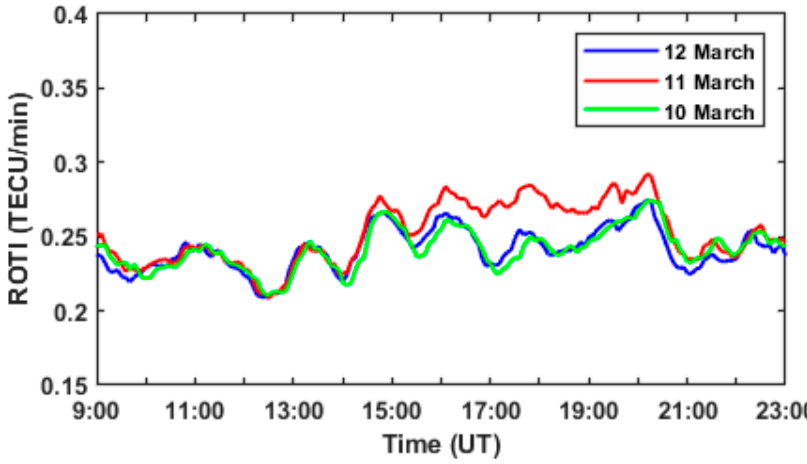
Figure 13. Average ROTI values for all satellites observed from all GPS stations on March 10 (green curve), 11 March (red curve), and 12 March (blue curve).